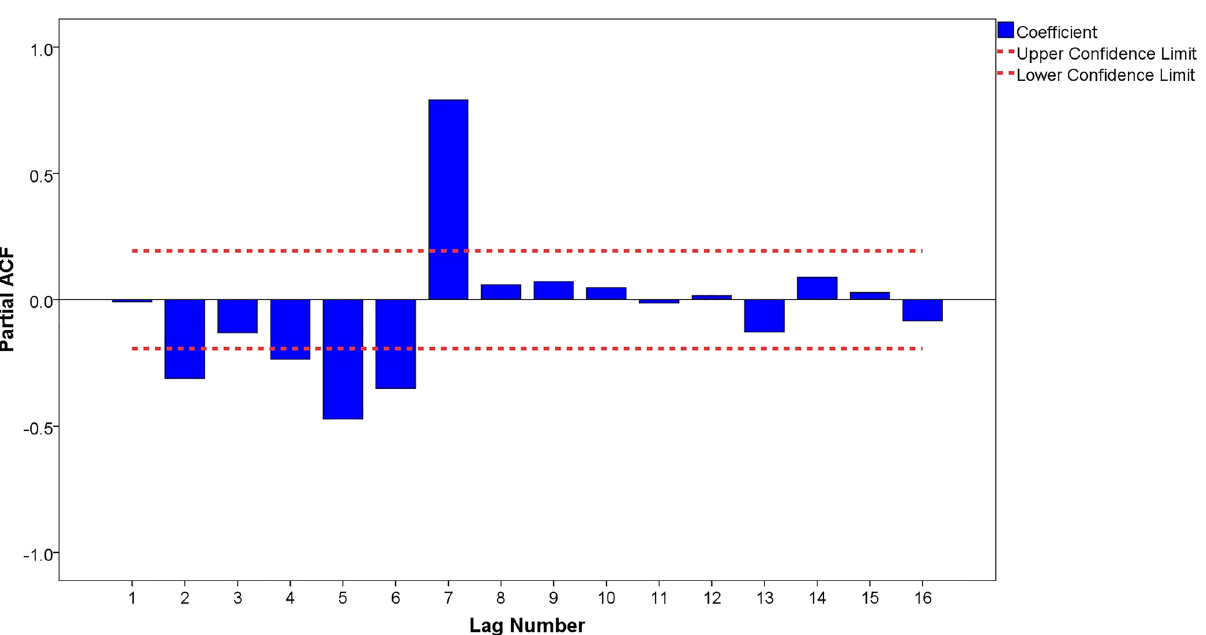
Figure.5. PACF chart of after the first-order difference and natural logarithm transformation.